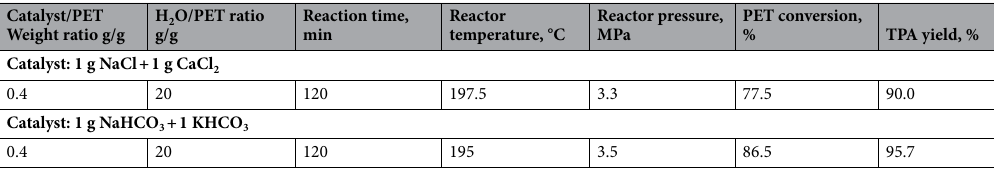
Table 3. Experimental data of PET depolymerization by hydrolysis using a double catalyst.